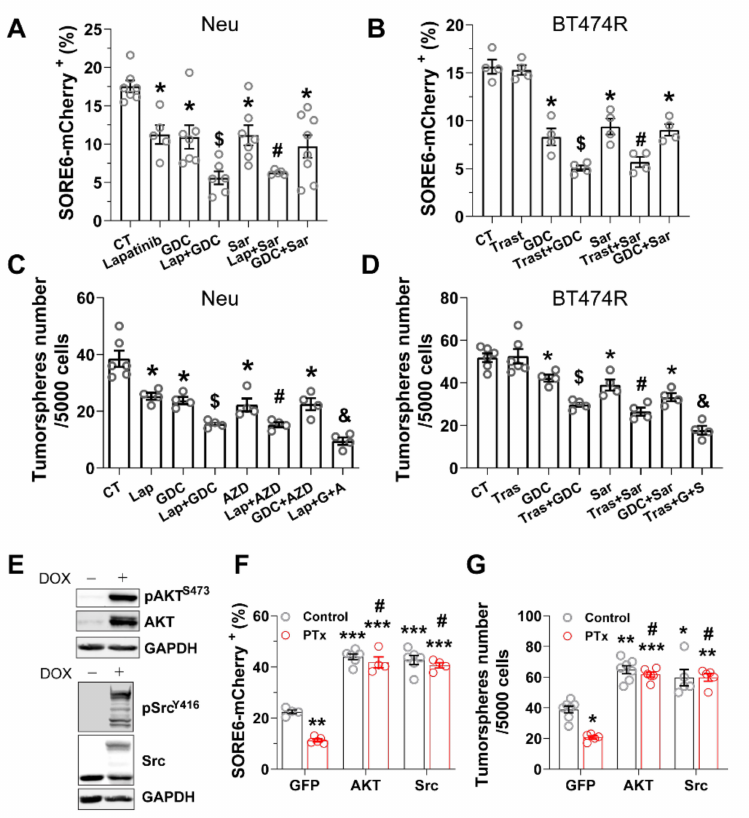
Figure 5. Gi/o-GPCRs signal through the PI3K/AKT and Src pathways to maintain CSC activities in HER2+ breast cancer cells. ( A – D ) Inhibiting PI3K and Src activities in Neu and BT474R cells reduces CSC populations ( A , B ) and tumorsphere formation ( C , D ). Cells were treated with lapatinib (1 µ M), GDC0941 (GDC, 0.1 µ M), saracatinib (Sar, 0.1 µ M), and trastuzumab (1 mg/mL), either alone or in combination, for 3 days for CSC analysis and 6 days for tumorsphere-formation assays. * p < 0.05 vs. CT; $ p < 0.05 vs. lapatinib, trastuzumab, and GDC alone; # p < 0.05 vs. lapatinib, trastuzumab, and Sar alone; p < 0.05 vs. lap + GDC, lap + Sar, Tras + GDC, Tras + Sar, and GDC + Sar. N = 4–7. ( E ) Western blotting showing induced expression of myristoylated AKT2 and GFP-tagged Src Y527F mutants in Neu cells, after 3 days of doxycycline (2 µ g/mL) treatment. ( F – G ) The effect of overexpressing active AKT2 and Src mutants on the response of Neu cells to PTx-mediated inhibition of CSC populations ( F ) and tumorsphere formation ( G ). *, **, *** p < 0.05, 0.01 and 0.001 vs. GFP control, respectively; # not significantly different vs. control. N =